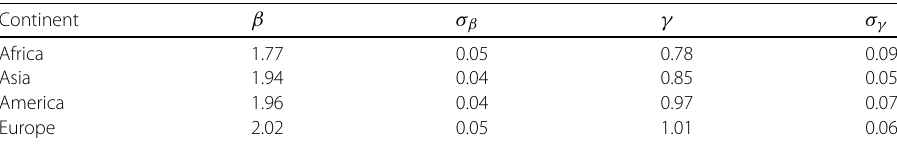
Table 1 Exponents of Zipf’s Law and Heaps’ Law. Column 1 displays β = 1 + α ; the PDF exponent of Zipf’s Law with corresponding standard deviation displayed in column 2 for each of the four continents. Values were calculated by fitting a line to the PDF of city sizes X for each continent, starting from a minimum population of X = 10 5 (see Fig. 2(a)). Column 3 displays γ ; the exponent of Heaps’ Law with corresponding standard deviation displayed in column 4 for each of the four continents. Values of γ and the error were obtained by fitting a line to the logarithm of Heaps’ Law; log( C ) = γ log( N ), for each continent (see Figs. 2(b)–(c) and (e)–(f)). Exponents β and γ were fit to the data using non-linear least squares Continent β σ β γ σ γ Africa 1.77 0.05 0.78 0.09 Asia 1.94 0.04